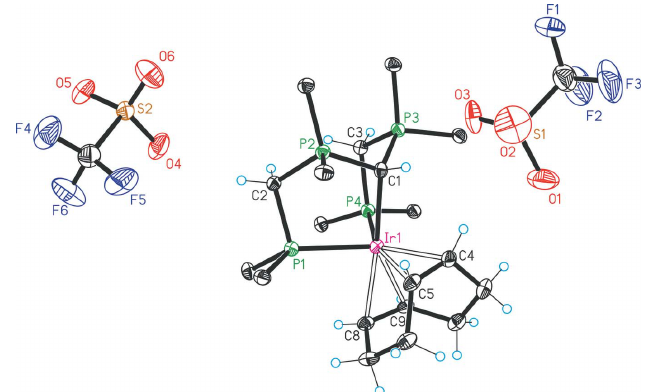
Figure 2 Structure of compound 2 , with atom labelling and 30% probability displacement ellipsoids. For clarity, only the ipso carbon atoms of the phenyl groups are shown, and the solvent molecules have been